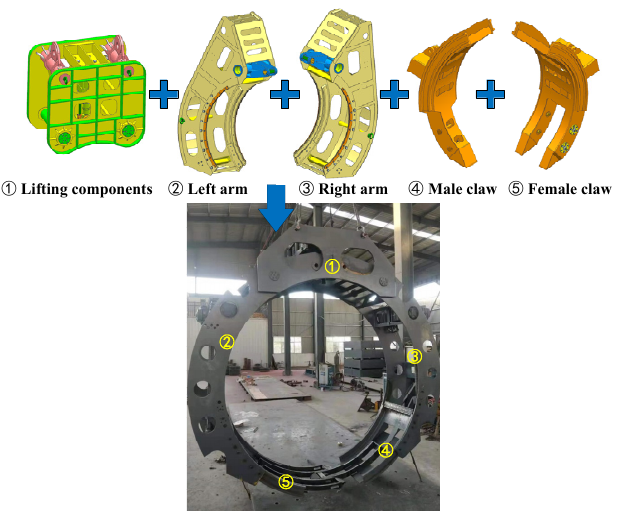
Figure 1. The manipulator. Two arms are fitted on the base; they have two hinges and can open and close using hydraulic cylinders. The two claws are retractable along arc guides on the arms. The parameters of the manipulator are listed in Table 1. Table 1. Parameters of the